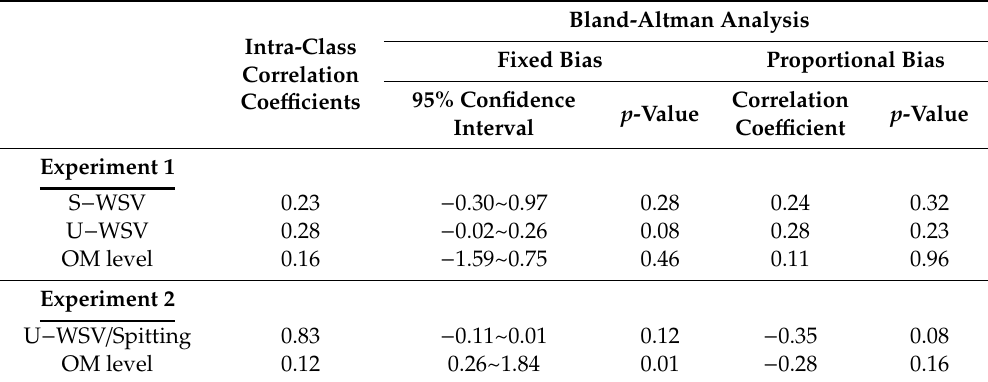
Table 3. Intra-class correlation coe ffi cients and systematic biases of each